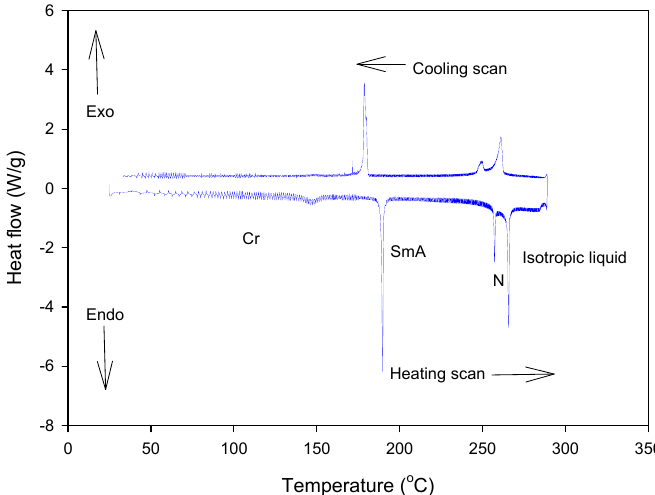
Figure 1. Di ff erential scanning calorimetry (DSC) thermograms of supramolecular acid 1 upon heating Figure 1. Differential scanning calorimetry ( DSC) thermograms of supramolecular acid 1 upon and cooling scans with heating rate 10 ◦ C / min. heating and cooling scans with heating rate 10 °C/min.